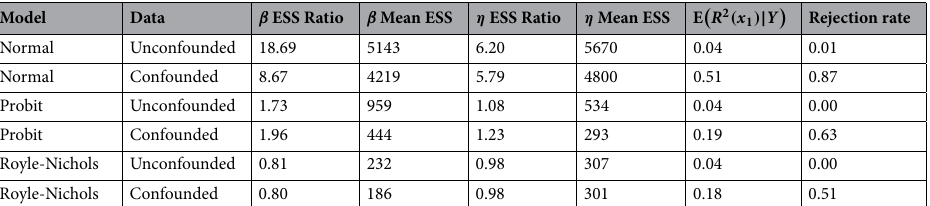
Table 1. Summary of simulations results. All results are averaged across 3 magnitudes of random species effects and 50 simulated datasets. ESS Ratio is the effective sample size of the restricted parameterizations over the unrestricted and the mean ESS is the average of the two. E R confounding for species 1 continuous habitat covariate. Rejection rate is the portion of times the the posterior mean p-value from overall F-test of a linear relationship between x 1 and (cid:31) was below